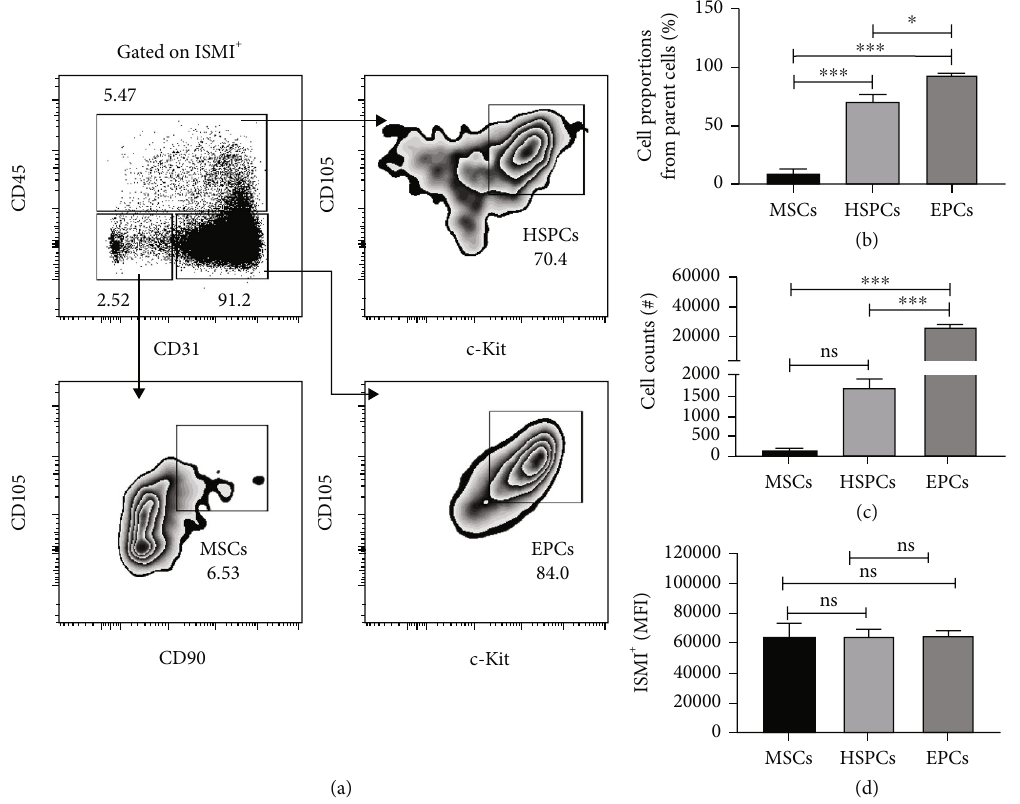
Figure 3: ISM1 + cells have a phenotype of progenitor cells related to endothelial, mesenchymal, and hematopoietic cells in the lung. (a) Lung whole ISM1 + cells were selected based on its CD45, CD31, CD105, c-kit, and CD90 expression, and subpopulations are shown. HSPCs (ISM1 + CD45 + CD31 - CD105 + c-kit + ), MSCs (ISM1 + CD45 - CD31 - CD105 + CD90 + ), and EPCs (ISM1 + CD45 - CD31 + CD105 + c-kit + ) are depicted. (b) Cell proportions of each subpopulation are plotted. (c) Total events corresponding to each subpopulation are plotted. (d) MFI of ISM1 + cells within each subpopulation are shown. Data shown are the mean plus SEM, n = 4 . Statistical analysis was performed by one-way ANOVA, ∗ p < 0 : 05 , ∗∗∗ p < 0 : 0001